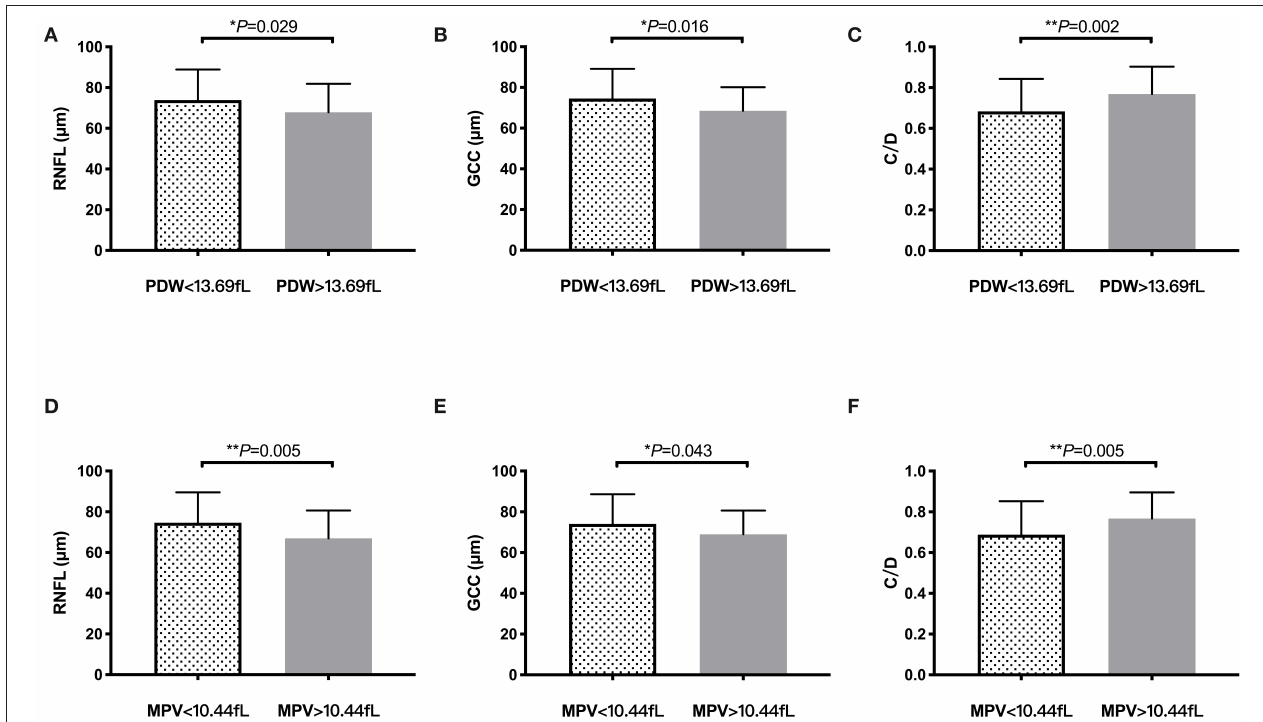
FIGURE 3 | OCT findings according to PDW and MPV levels in primary open-angle glaucoma (POAG). Bar columns represent mean ± SD of OCT parameters in patients with POAG with different platelet PDW (PDW > 13.69 vs. < 13.69 fL) and MPV (MPV > 10.44 vs. < 10.44 fL) levels. * P < 0.05, ** P < 0.01. (A) RNFL thickness in PDW subgroup. (B) GCC thickness in PDW subgroup. (C) C/D in PDW subgroup. (D) RNFL thickness in MPV subgroup. (E) GCC thickness in MPV subgroup. (F) C/D in MPV subgroup. PDW, platelet distribution width; MPV, mean platelet volume; RNFL, retinal nerve fiber layer; GCC, ganglion cell complex; C/D, cup/disc area